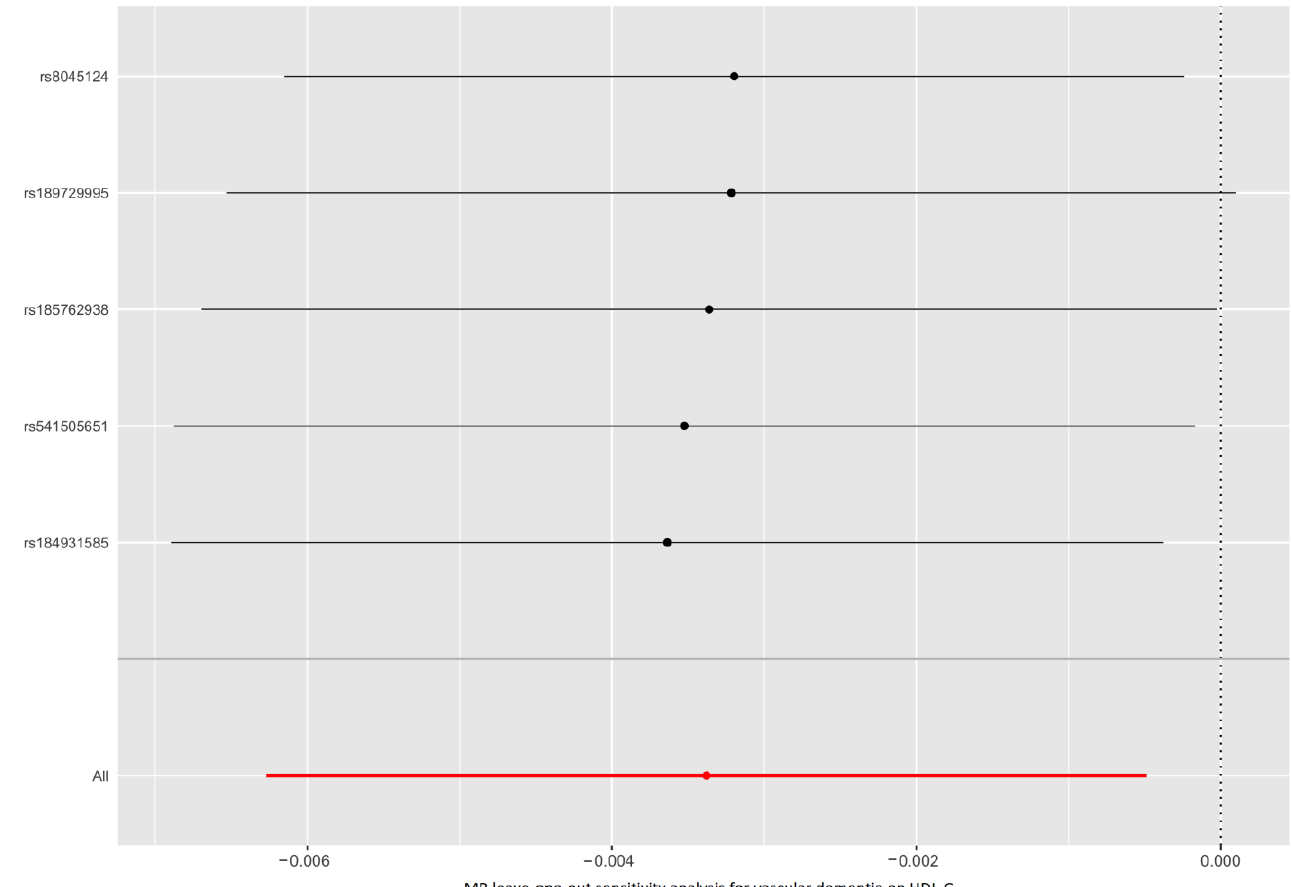
Figure 3. Leave-one-out permutation analysis of the causal association between VaD and HDL-C level. VaD: vascular dementia; HDL-C: high-density lipoprotein cholesterol; MR: Mendelian randomization; SNP: single nucleotide polymorphism.